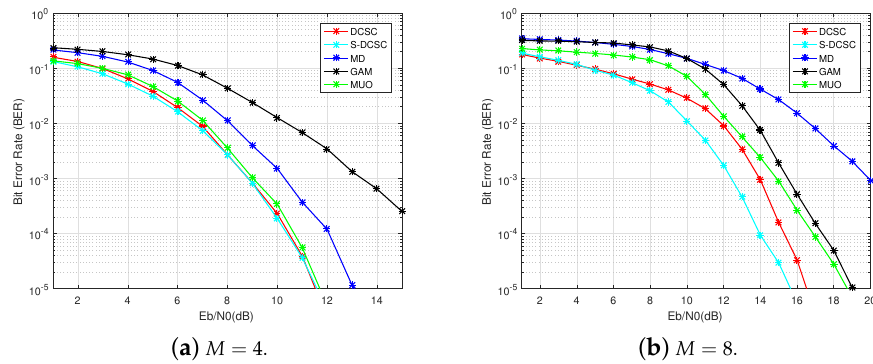
Figure 4. Comparison of BER performance of different codebook design schemes.